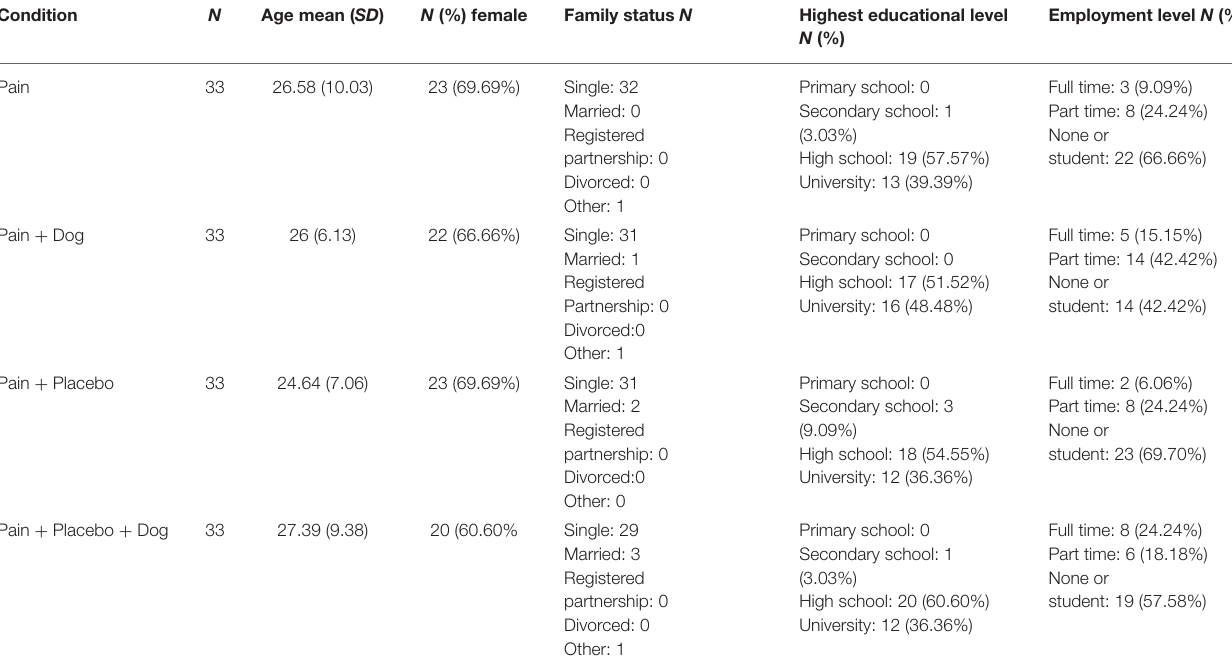
TABLE 1 | Sociodemographic characteristics of participants.